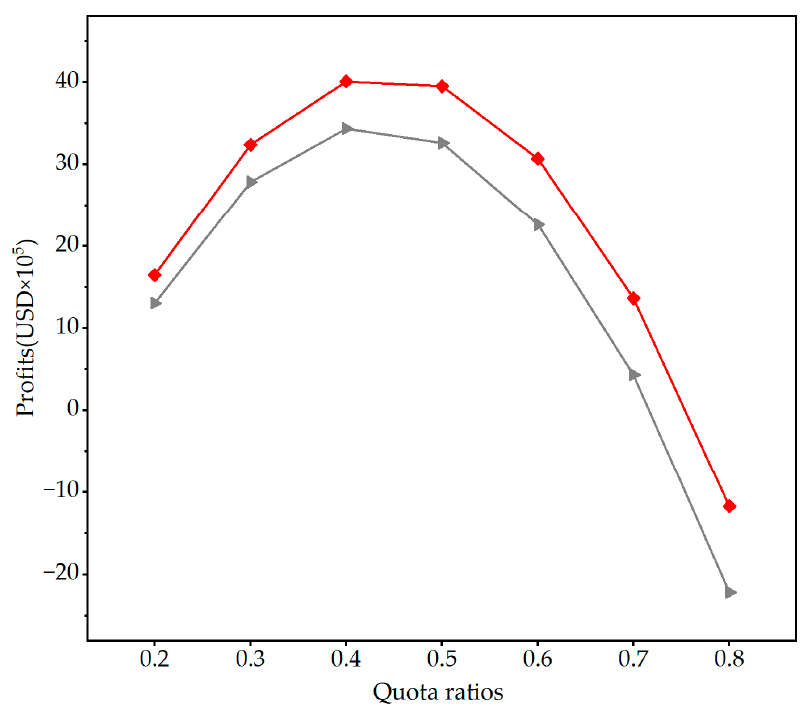
Figure 8. Different quota ratios under the mixed and non-mixed decision-making profits of electricity sales companies.